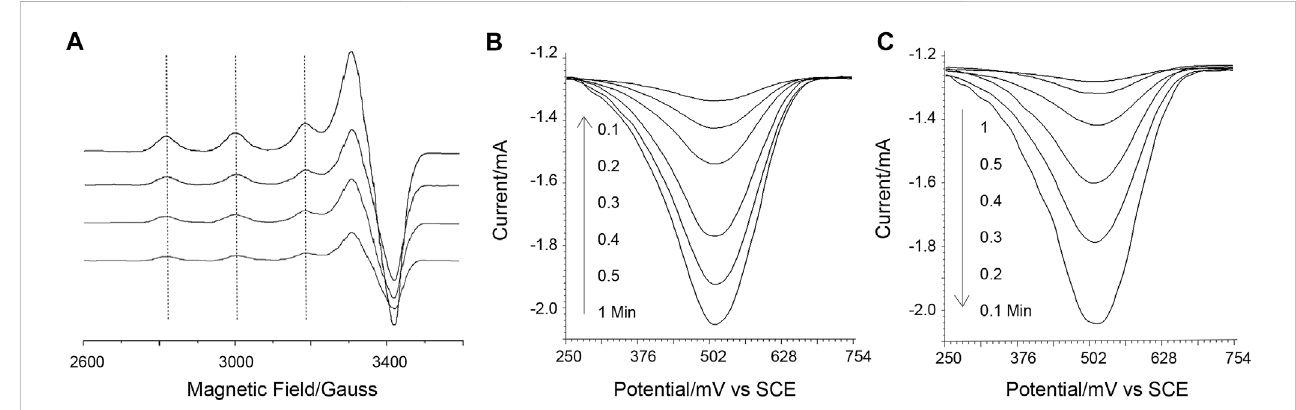
FIGURE 2 (A) X-band electron paramagnetic resonance responses. (B, C) is the square wave voltammetric responses of poly-tyrosine detected on the sensing surface and in the solution, sampled at a gradually longer time of electrochemical scanning (as marked on the graphs). A background as studied in Supplementary Figure S5 has been subtracted from the data, and this also applies to the next square wave voltammetric responses of poly-tyrosine.